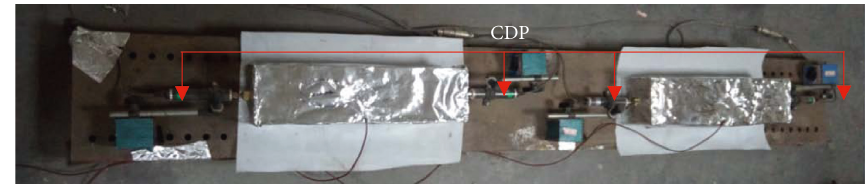
Figure 4: Physical map of autogenous deformation test. Table 4: Experimental results of mechanical property related to tensile